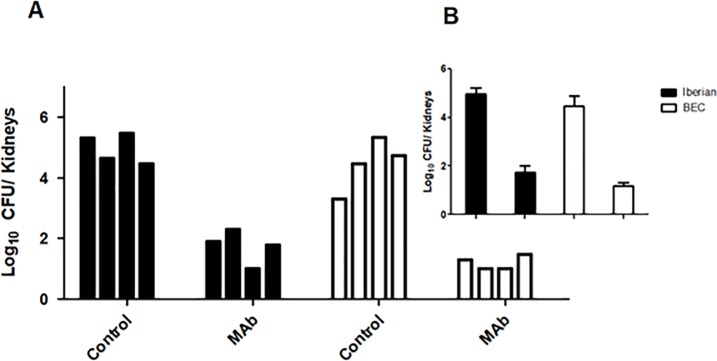
Bacterial load in kidneys after systemic infection with different MRSA strains.Groups (four mice per group) of treated (MAb) and untreated (control) mice were infected via IP injection with 2.4x108 CFU of Iberian (black) or 1.6x108 BEC (white) MRSA clones, and bacterial quantitation was performed after 5 days. A. Bacterial load in individual mice: Iberian Control (2.1x105, 4.4x104, 3.1x105, and 2.9x104 CFU); Iberian MAb-treated (8.0x101, 2.0x102, 1.0x101, and 6.0x101 CFU); BEC control (2.0x103, 2.9x104, 2.2x105, and 5.2x104 CFU); BEC MAb-treated (2.0x101, 1.0x101, 1.0x101, and 3.0x101 CFU) (*p<0.05 for Iberian and BEC assays). B. Comparative mean for both groups challenged with Iberian and BEC MRSA, respectively (Iberian control: 2.11x105 CFU; Iberian MAb treated: 8.75x101 CFU; BEC control: 7.57x104 CFU; BEC MAb treated: 1.75x101 CFU).